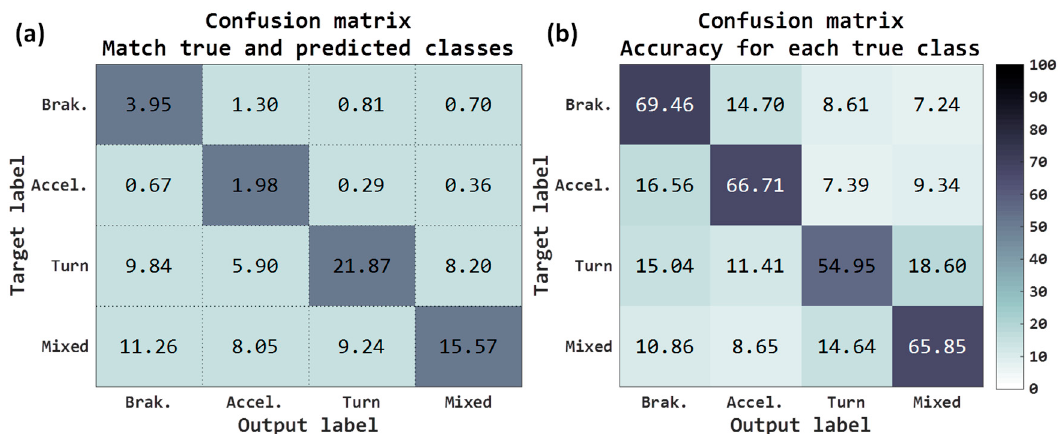
Figure 9. Confusion matrix on horizontal projections tests: ( a ) according to the number of tested maneuvers, ( b ) according to the type of maneuver.